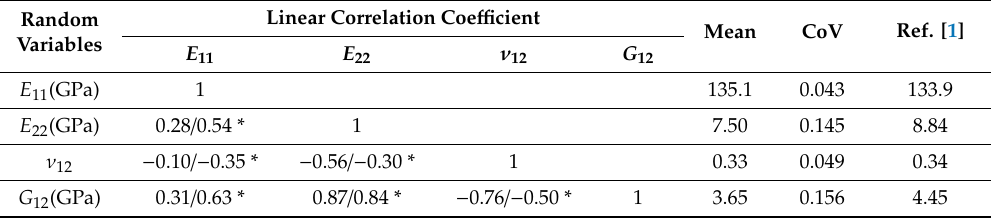
Figure 8. Typical specimen strain distribution measured by DIC: ( a ) ε x ; ( b ) ε y ; ( c ) γ xy. Table 3. Statistics of unidirectional CFRP elastic properties derived from experiments.